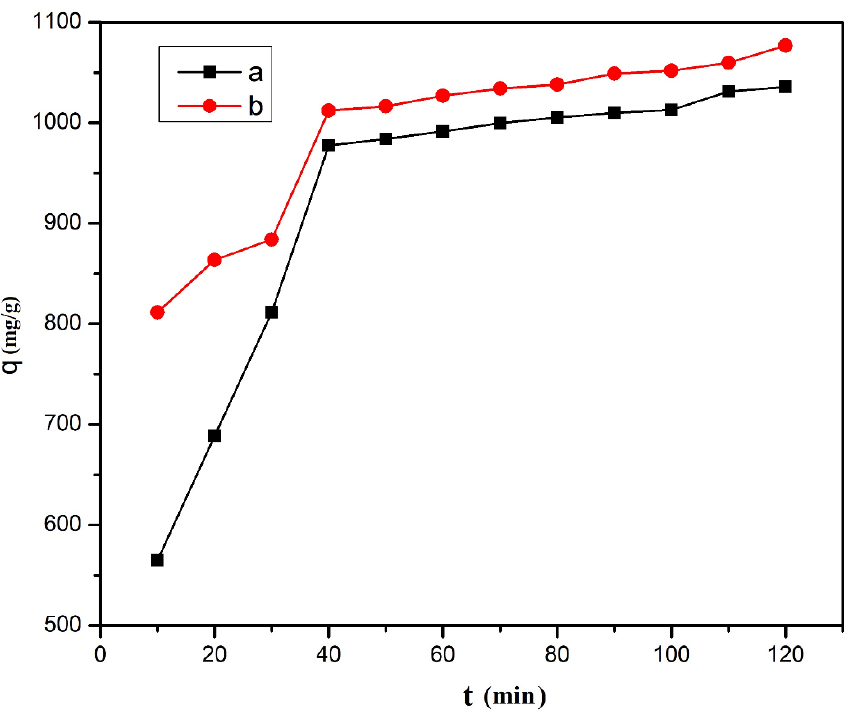
Figure 11. Adsorption capacity of ( a ) CQVP/MA and ( b ) CQVP/MA-Fe 3 O 4 against time for CBB in its aqueous solution at room temperature.